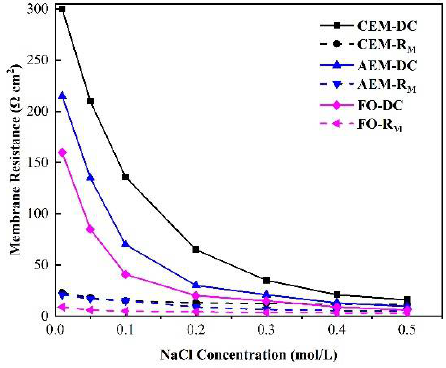
11 of 15 Figure 11. ( a ) The impedance of the Nyquist spectrum and ( b ) membrane the impedance(R M ), dou- ble layer impedance (R DL ), and diffusion layer impedance (R DBL ) of the FO membrane in 0.5 M NaCl solution. Figure 12 demonstrates the relationship between the membrane impedance meas- ured by the DC and AC approaches and the concentration of the external solution. It can be seen from the figure that there was a high correlation between the membrane imped- ance, as measured by DC or AC impedance spectroscopy, and the concentration of the